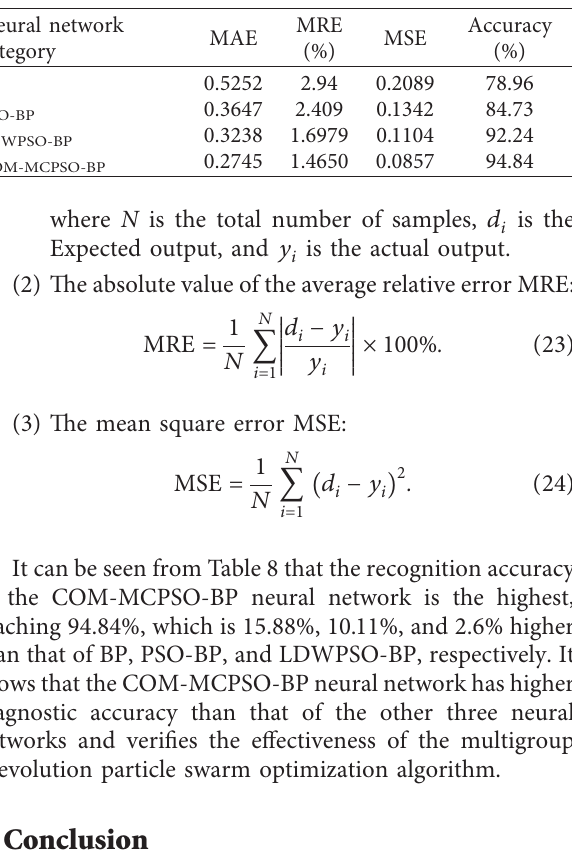
Table 8: Network performance